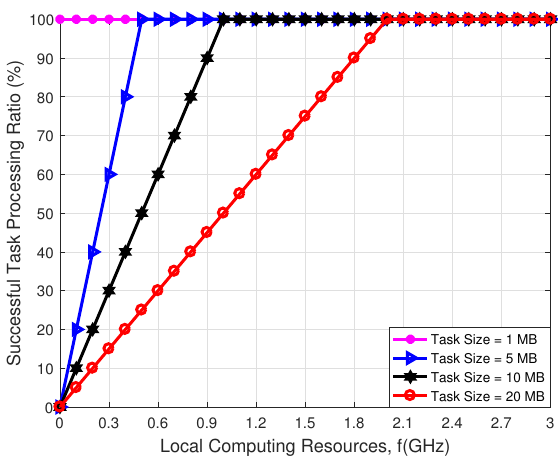
Figure 11. Comparison of the successful task processing ratio with respect to the local computation resources under different task sizes.